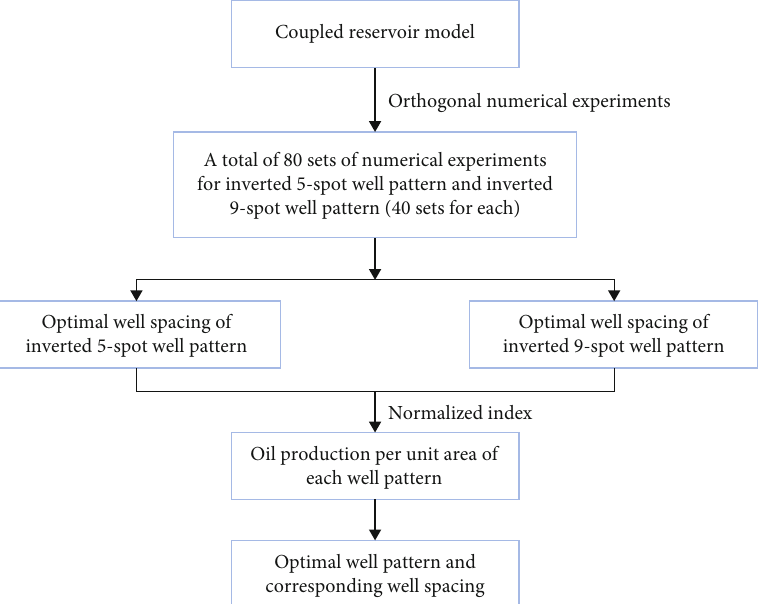
Figure 1: Flowchart of the